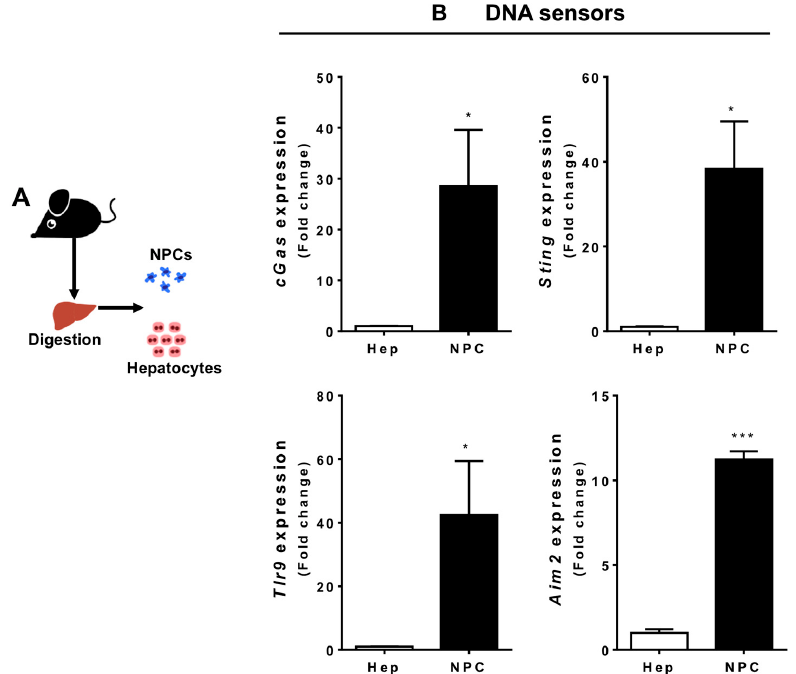
Figure 3. DNA sensor expression in different liver cell populations. ( A ) Scheme showing two groups of isolated hepatic cells—parenchymal (hepatocytes) and non-parenchymal (NPCs) cells—from healthy mice. ( B ) Gene expression comparison of different DNA and cytokine sensors between these two populations. The graphs represent the mean expression of selected genes relative to hepatocytes ( ΔΔ CT). (Mean ± SEM; n = 4); * p ≤ 0.05 and *** p ≤ 0.001 compared to hepatocytes.